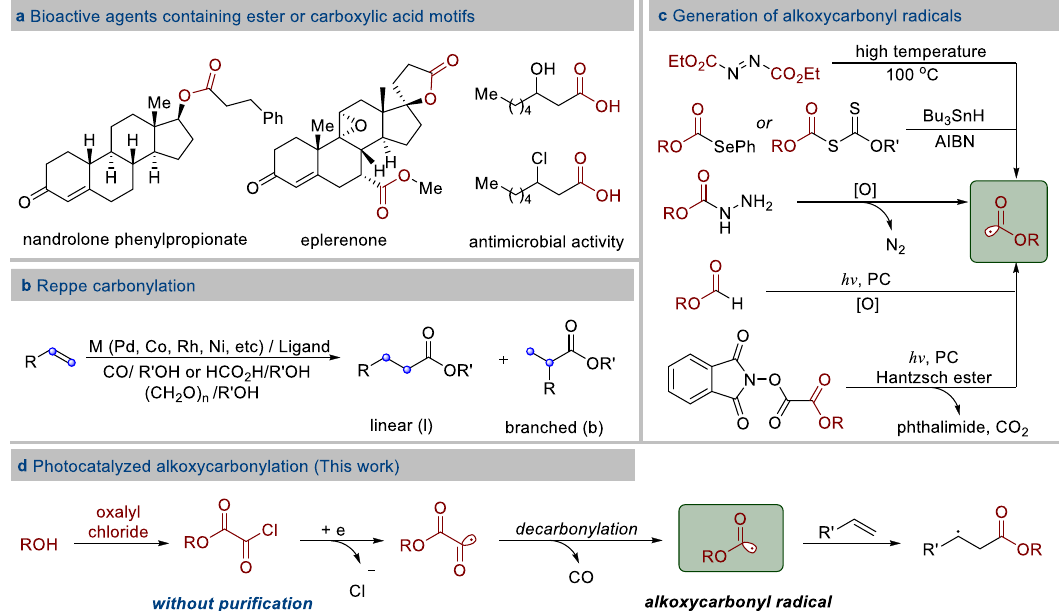
Fig. 1 Bioactive carboxylic derivatives and approaches for their synthesis. a Bioactive agents containing ester or carboxylic motifs. b Reppe carbonylation. c Generation of alkoxycarbonyl radicals. d This